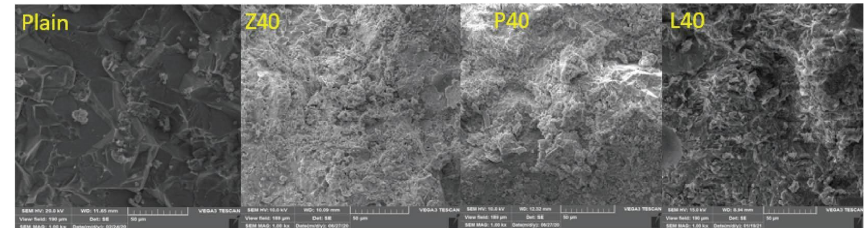
Figure 14: SEM images of plain, Z40, L40, and P40 mixture at the age of